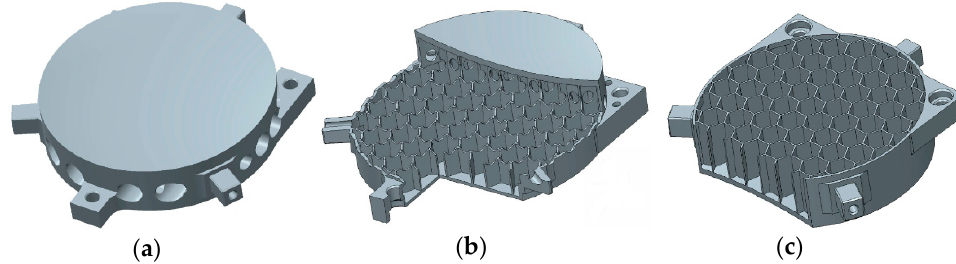
Figure 16. Several structural diagrams: ( a ) CAD model of the “drill”; ( b ) CAD model of the honeycomb mirror with sectioning planes added to demonstrate the hollow structure; ( c ) Honeycomb mirror with open backside [33].